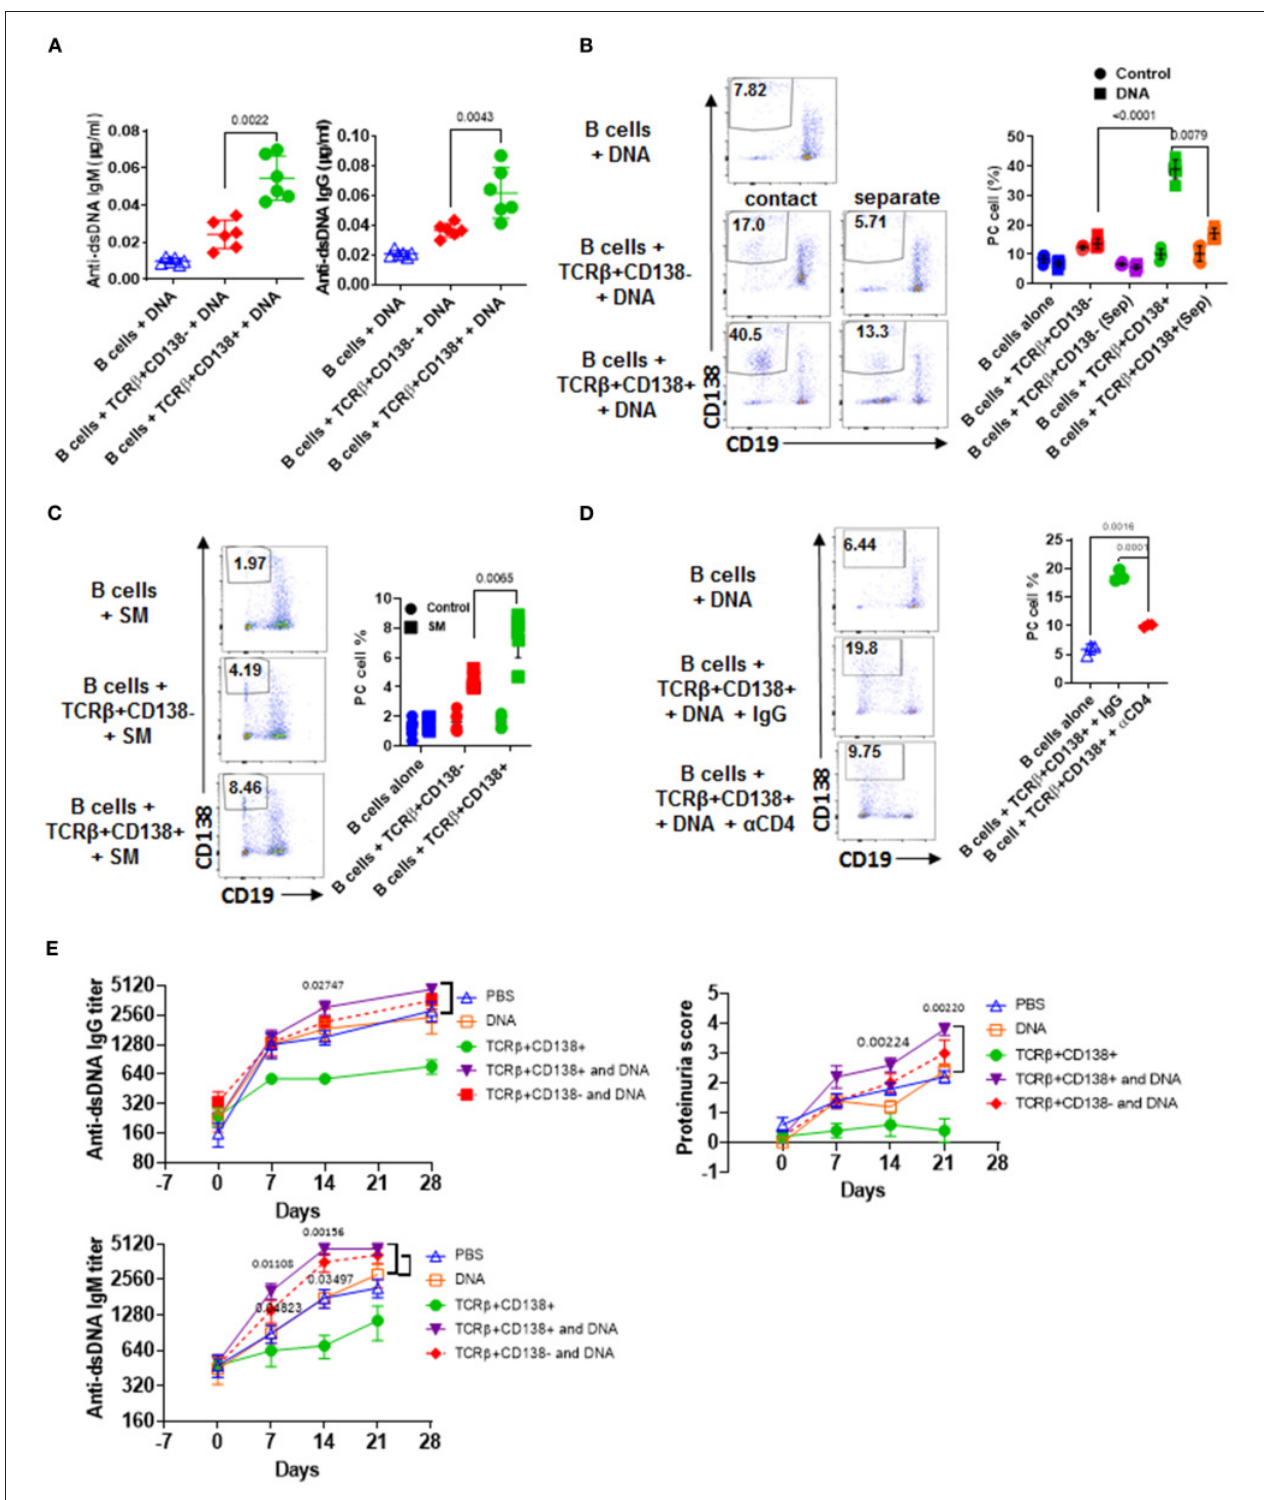
FIGURE 5 | TCR β + CD138 + cells activate autoreactive B cells when auto-antigens are included in the culture. (A–D) Sorted splenic TCR β + CD138 + and TCR β + CD138- cells from 12 weeks old MRL/Lpr mice were co-cultured with purified splenic B cells from the same mice for 5 days. (A) DNA was included in